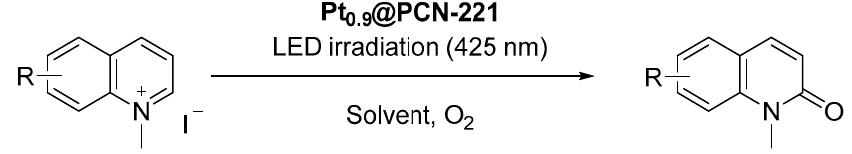
Table 9. Various photooxidation reactions mediated by